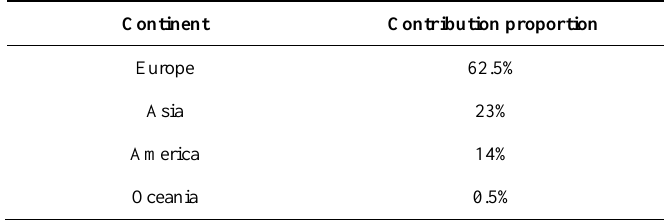
Table 1. Contribution proportion of world universities\institutes among studied works between 2014 and